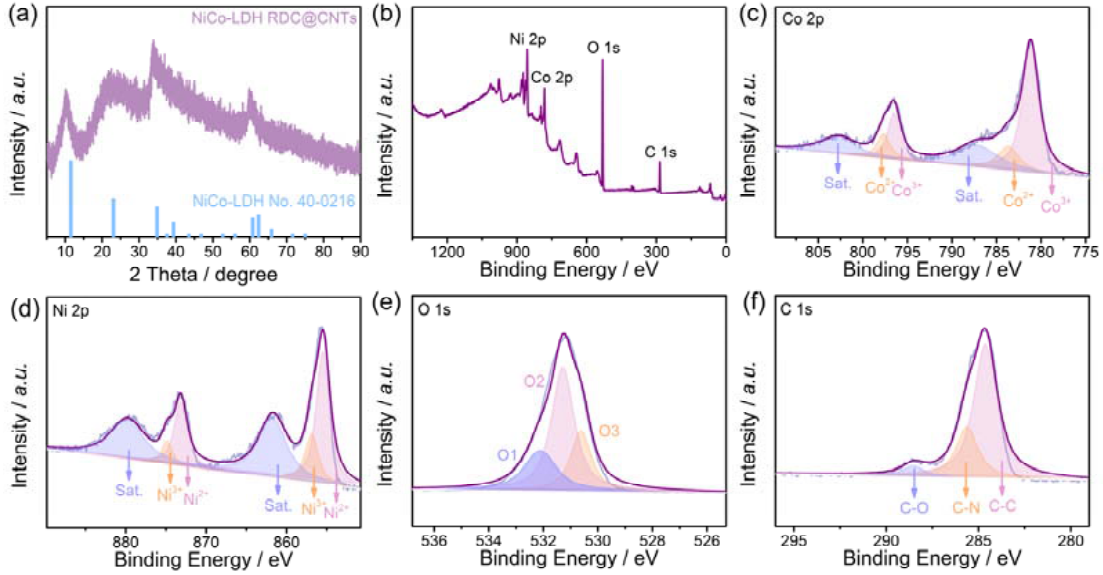
Figure 2. ( a ) XRD pattern; ( b ) survey scan XPS spectrum; high ‐ resolution ( c ) Co 2 p , ( d ) Ni 2 p , ( e ) O 1 s , and ( f ) C 1 s XPS spectrums of NiCo ‐ LDH RDC@CNTs.